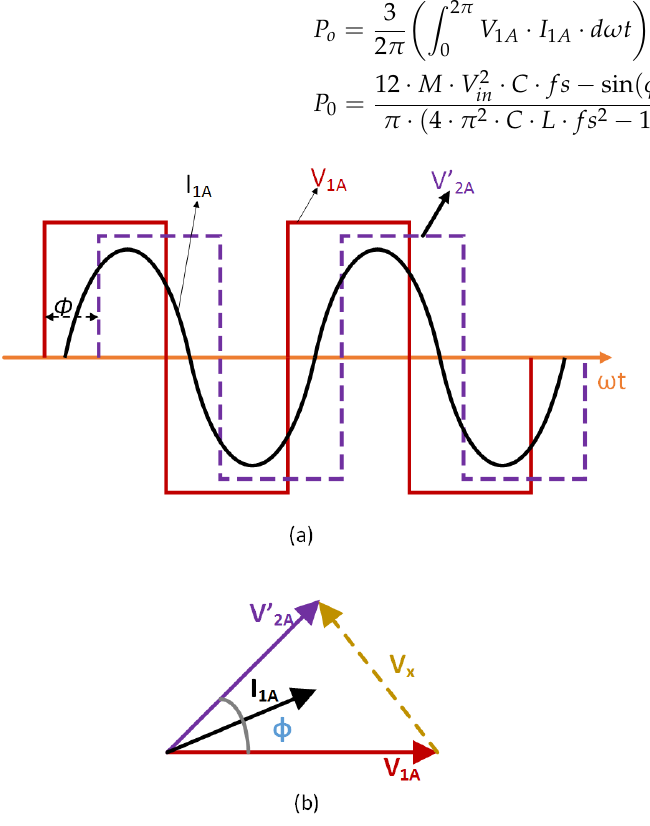
Figure 9. ( a ) Voltage and current waveform. ( b ) Voltage and current